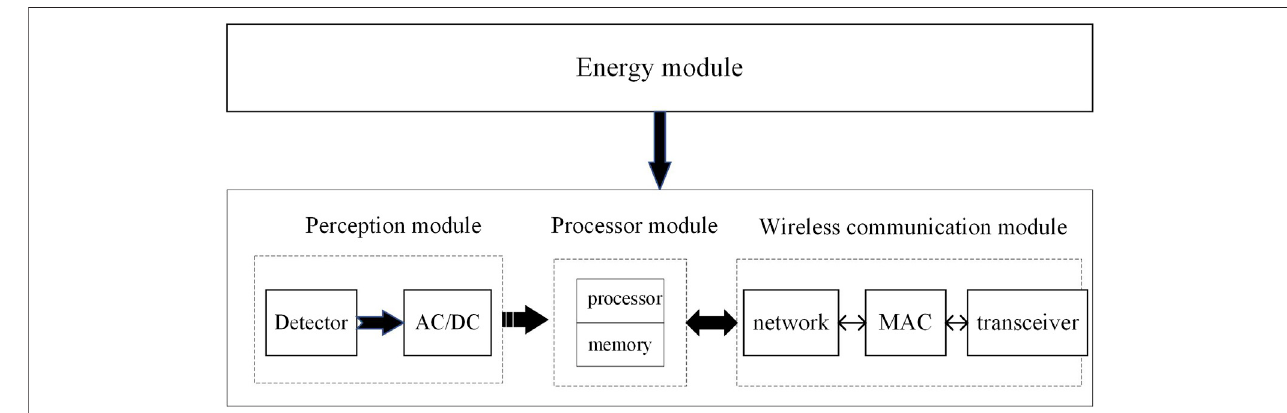
FIGURE 1 | Detector node structure diagram.